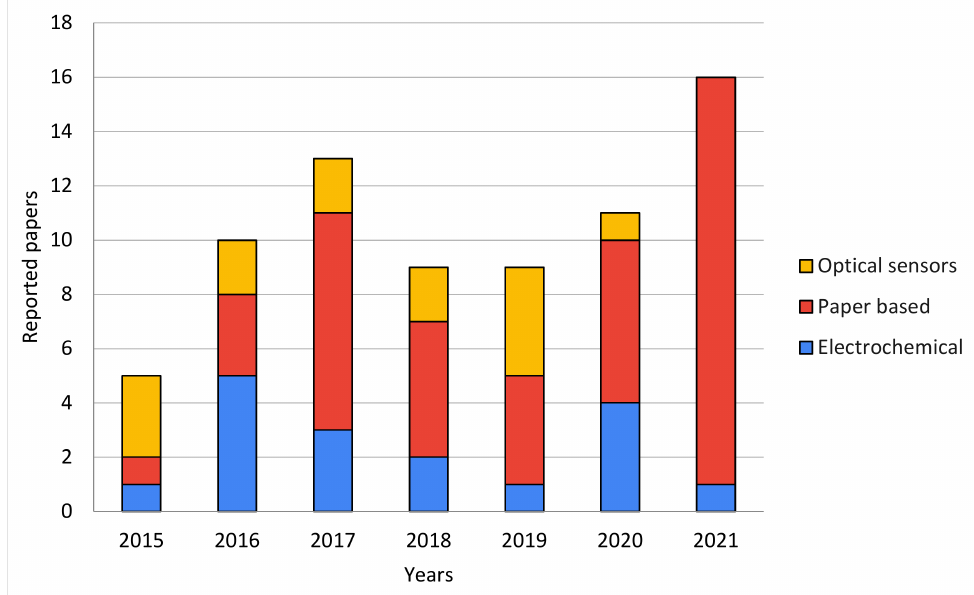
Figure 2. Publications trend of smartphone-based biosensors over the years by type of technology.